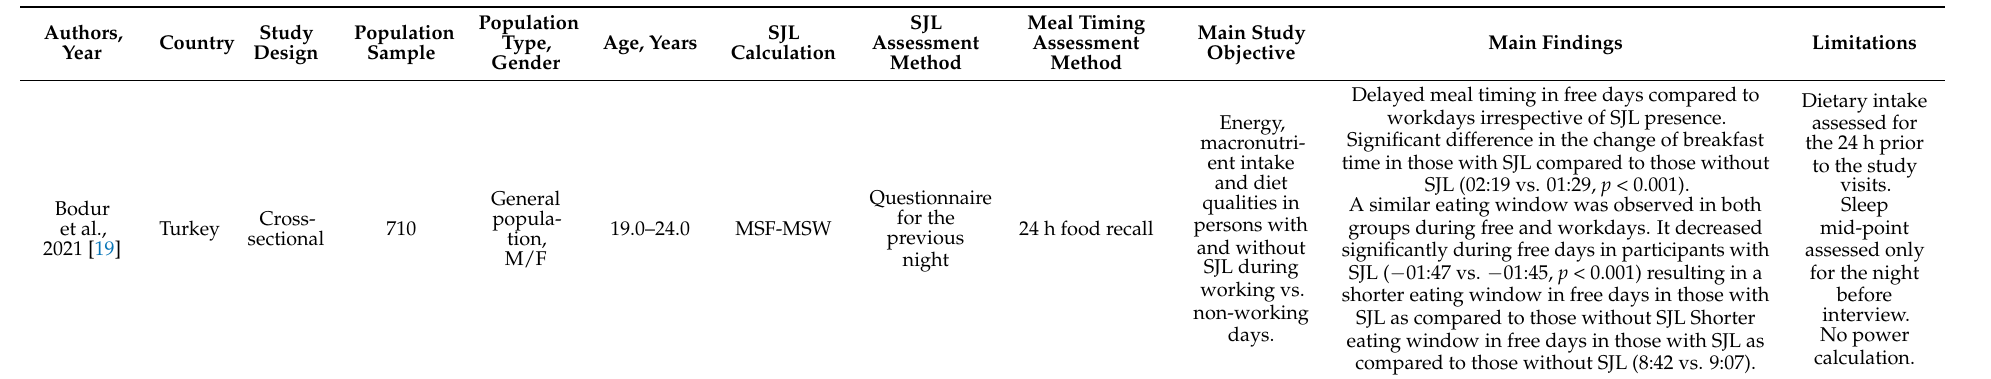
Table 2. Studies reporting the association of social jetlag with meal